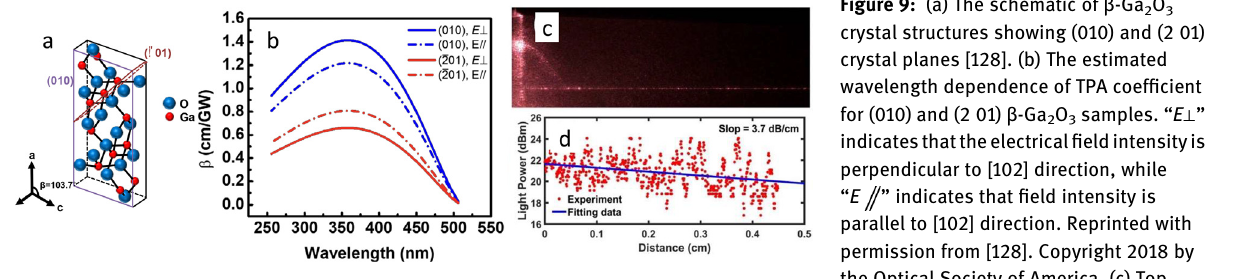
Figure 9: (a) The schematic of β -Ga 2 O 3 crystal structures showing (010) and (2 01) crystal planes [128]. (b) The estimated wavelength dependence of TPA coef fi cient for (010) and (2 01) β -Ga 2 O 3 samples. “ E ⊥ ” indicatesthattheelectrical fi eldintensityis perpendicular to [102] direction, while “ E ” indicates that fi eld intensity is parallel to [102] direction. Reprinted with permission from [128]. Copyright 2018 by the Optical Society of America. (c)